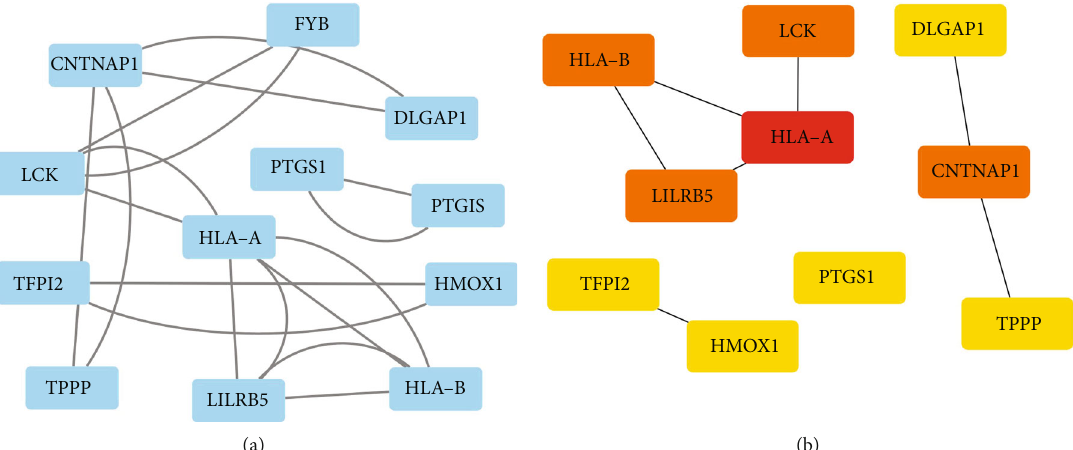
Figure 4: PPI network analysis of common DEGs in GSE140202 and GSE143233. (a) PPI network of DEGs. (b) Submodules of DEGs were extracted by cytoHubba of Cytoscape software.